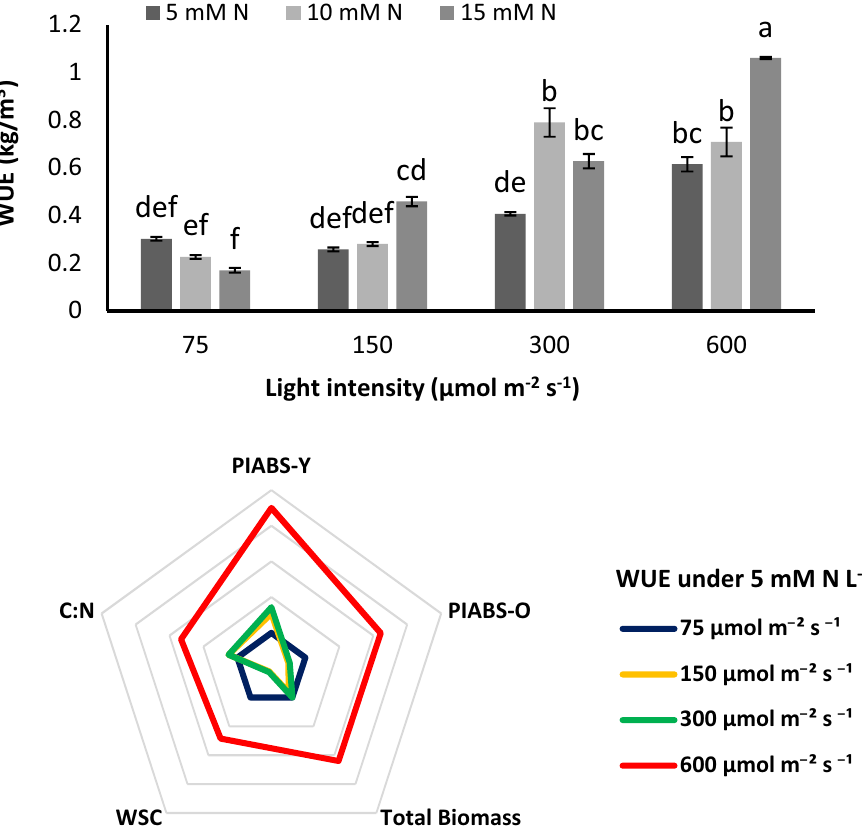
Figure 6. Water use efficiency (WUE) ( A ) of chrysanthemum plants grown under different light intensits (75, 150, 300, and 600 µmol m −2 s −1 ) and nitrogen (N) concentrations (5, 10, and 15 mM N) at 70 days of cultivation. The correlation between WUE with performance index per absorbed light (PI ABS ), total biomass, WSC, and C:N ration of plants fed by 5 mM N with under differenty light intensities (150, 300, and 600 µmol m −2 s −1 ) compared to that of plants under 75 µmol m −2 s −1 ( B ). Vertical bars are means ± SD. Within each graph, interactive effects of light intensity and nitrogen concentration are shown. Different letters (a–d) denote a significant difference between treaments (P < 0.05).